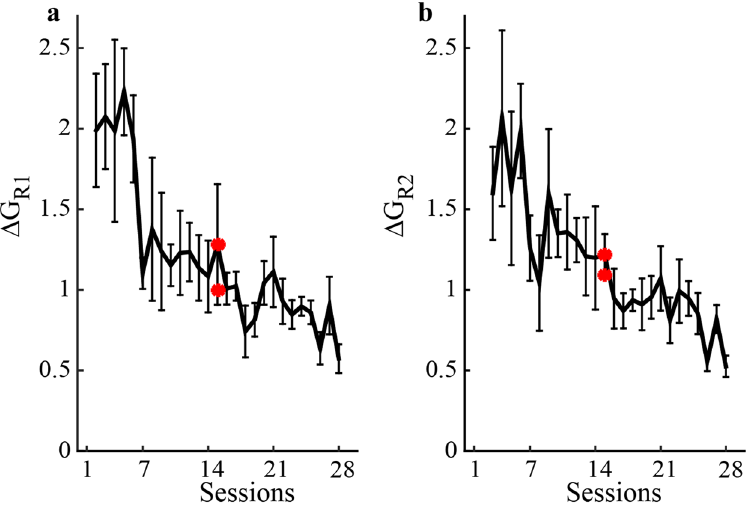
Figure 5. Evolution of the body strategy during reaching tasks. ( a and b ) difference across sessions of the inverse map G estimated from the body and the targets’ coordinates during the 1 st and 2 nd block of reaching respectively. The red stars indicate the comparison of the G estimated after and before the changes at the